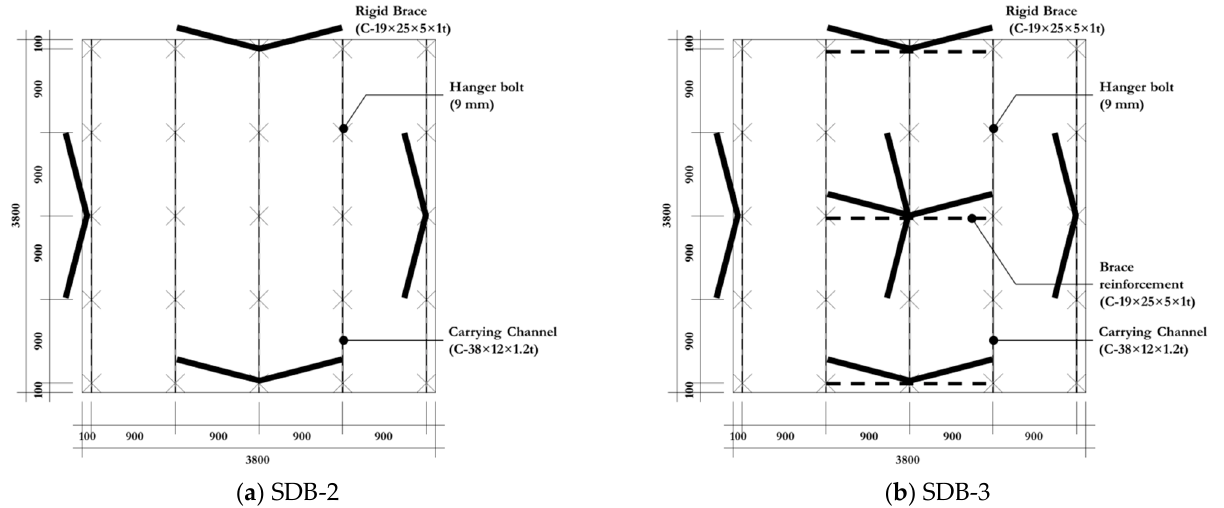
Figure 6. Brace installation of the specimens: ( a ) plan view of Seismic Design applying Brace 2 unit (SDB-2) and ( b ) plan view of Seismic Design applying Brace 3 unit (SDB-3).